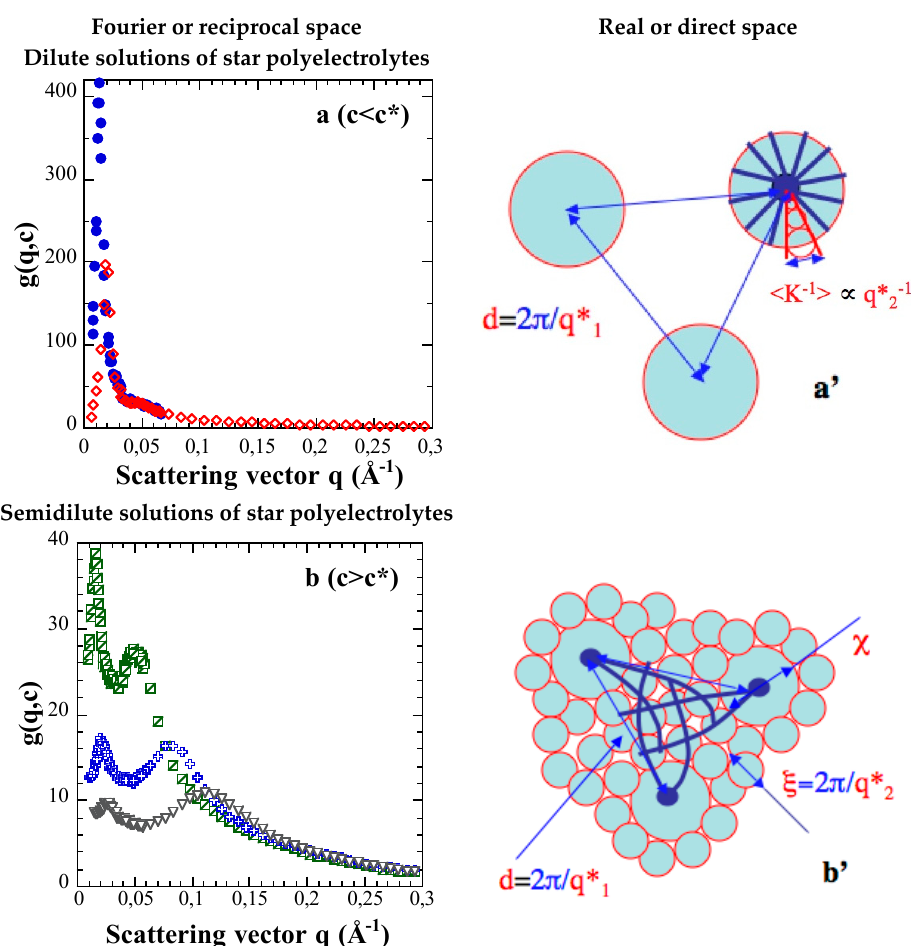
Figure 6. Fourier space ( a , b ) versus real space ( a’ , b’ ). Relation between the positions of the main maxima of the NaPSS scattering functions in the reciprocal space ( q 1 * and q 2 *) and the mean distances characterizing the average structure of the NaPSS star solutions in the direct space (d, < κ i > − 1 , χ and ξ ). ( a and a’ ) S100-S91/D 2 O ( c < c * ≈ 0.075 mol·L − 1 – φ < φ * ≈ 0.83%); c = 0.013 mol·L − 1 – φ = 0.14% (dotted circles); c = 0.052 mol·L − 1 – φ = 0.58% (lozenges); ( b and b’ ) S300-S94/D 2 O ( c > c * ≈ 0.010 mol·L − 1 – φ < φ * ≈ 0.11%); c = 0.088 mol·L − 1 – φ = 0.98% (crossed squares); c = 0.230 mol·L − 1 – φ = 2.57% (crosses); c =